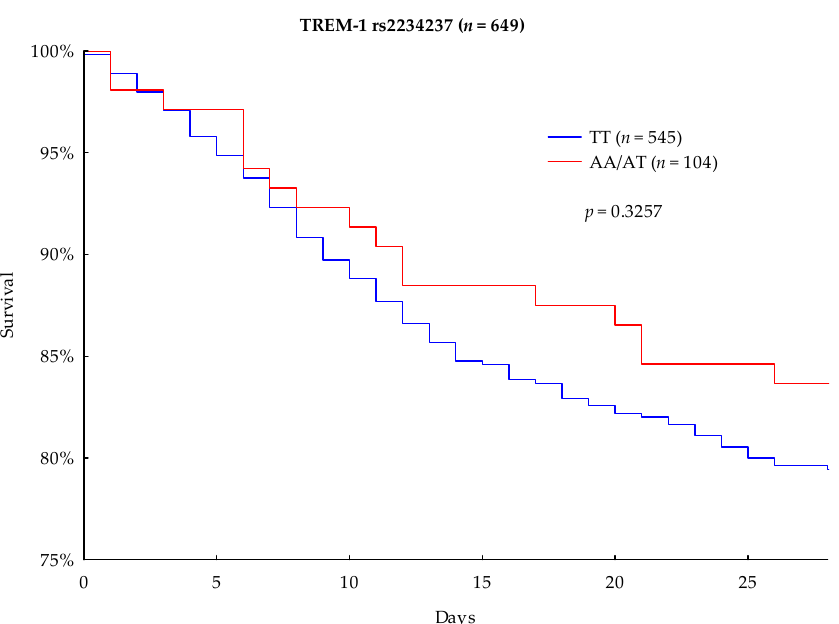
Figure 2. Kaplan–Meier 28-day survival analysis with regard to TREM-1 rs2234237 genotypes.